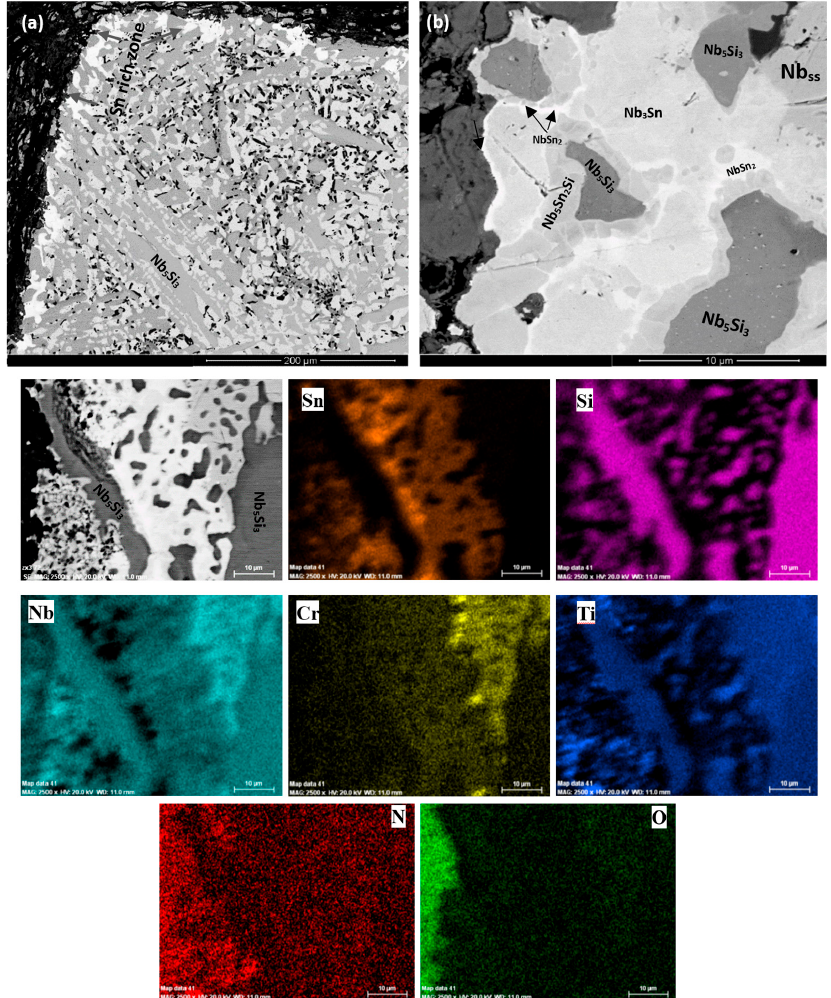
Figure 5. ( a , b ) BSE images of cross section, and X-ray elemental maps of the Sn rich zone of the oxidized alloy ZX3 at 1200 °C.